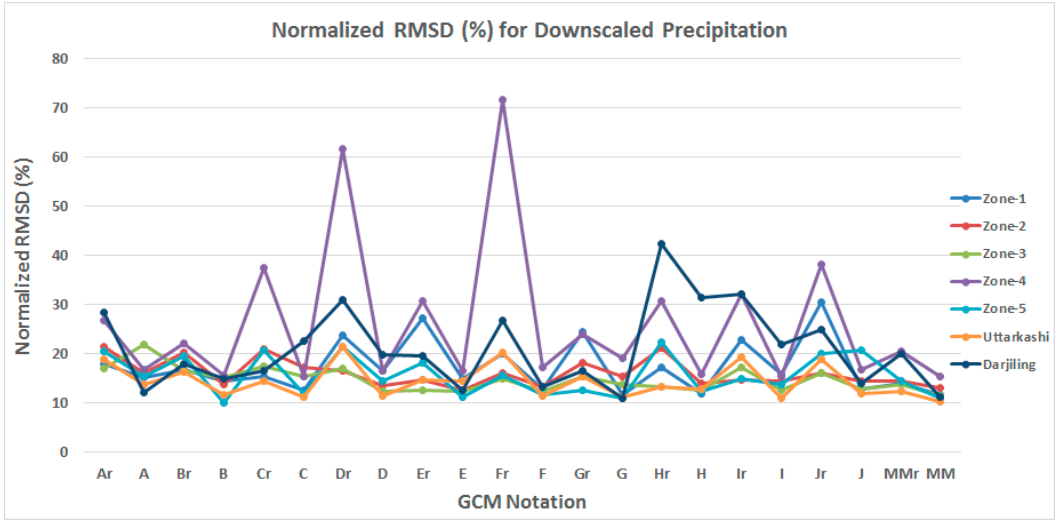
Figure 16. Normalized Root Mean Square Difference (%) of GCMs for downscaling precipitation with Re-Obs and GCM-Obs models. GCM notations are same as used in Figure 8. Correlation coe ffi cient (r) is a good measure to check linear similarity between two